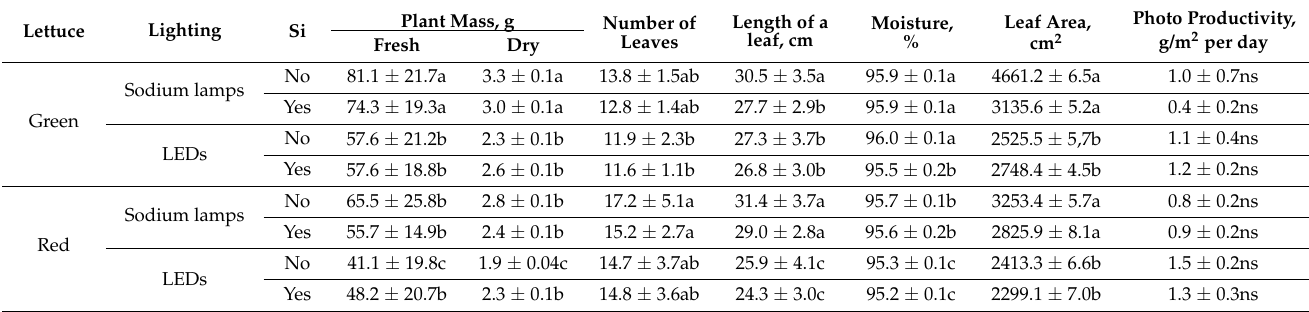
Table 5. Averaged biometric parameters of the aerial part of green and red lettuce ( Lactuca sativa L.) under conditions of a regulated agroecosystem on the 45th day of cultivation. Values represent mean ± SE ( n = 12). The different letters indicate significant differences among treatments and ns means non-significant differences among treatments according to Duncan’s test ( p ≤